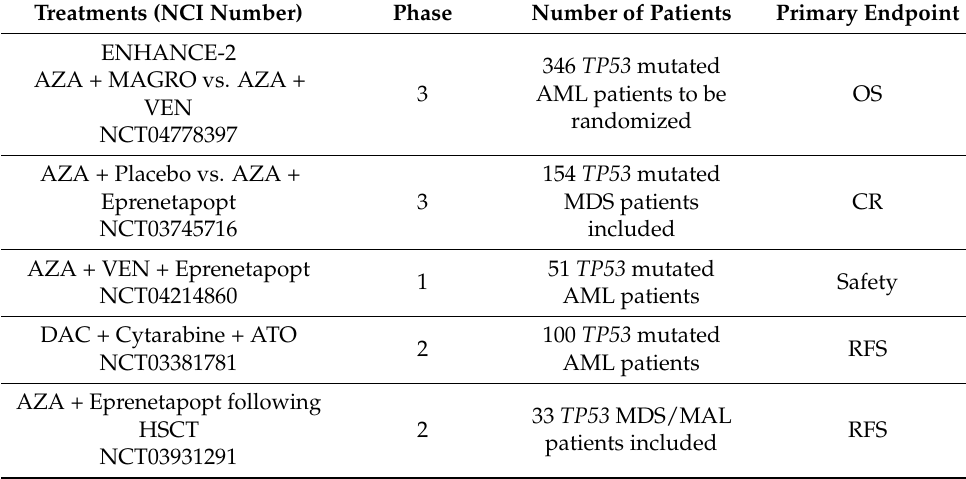
Table 2. Clinical trials ongoing in TP53 myeloid